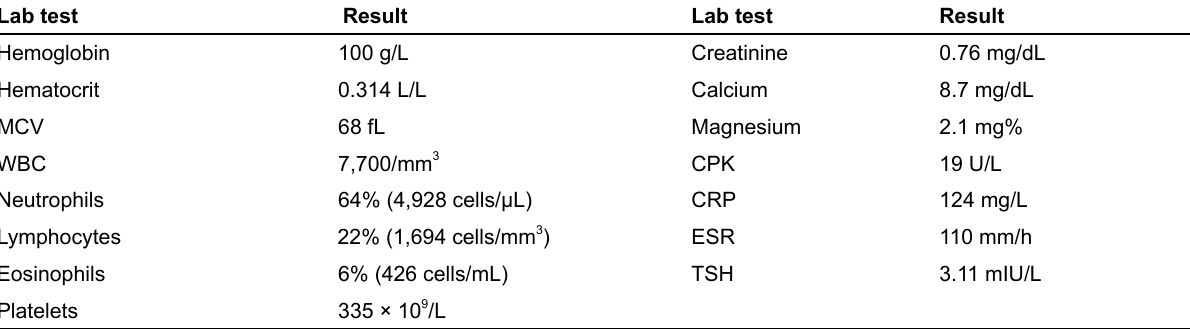
Table 1. Laboratory blood tests upon admission